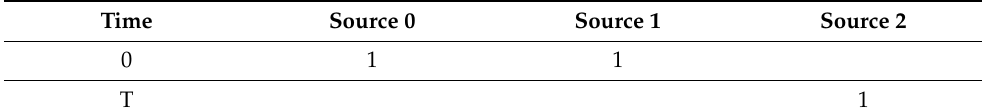
Figure 2. Example topology. Table 3. Packet generation scenario in the example topology.